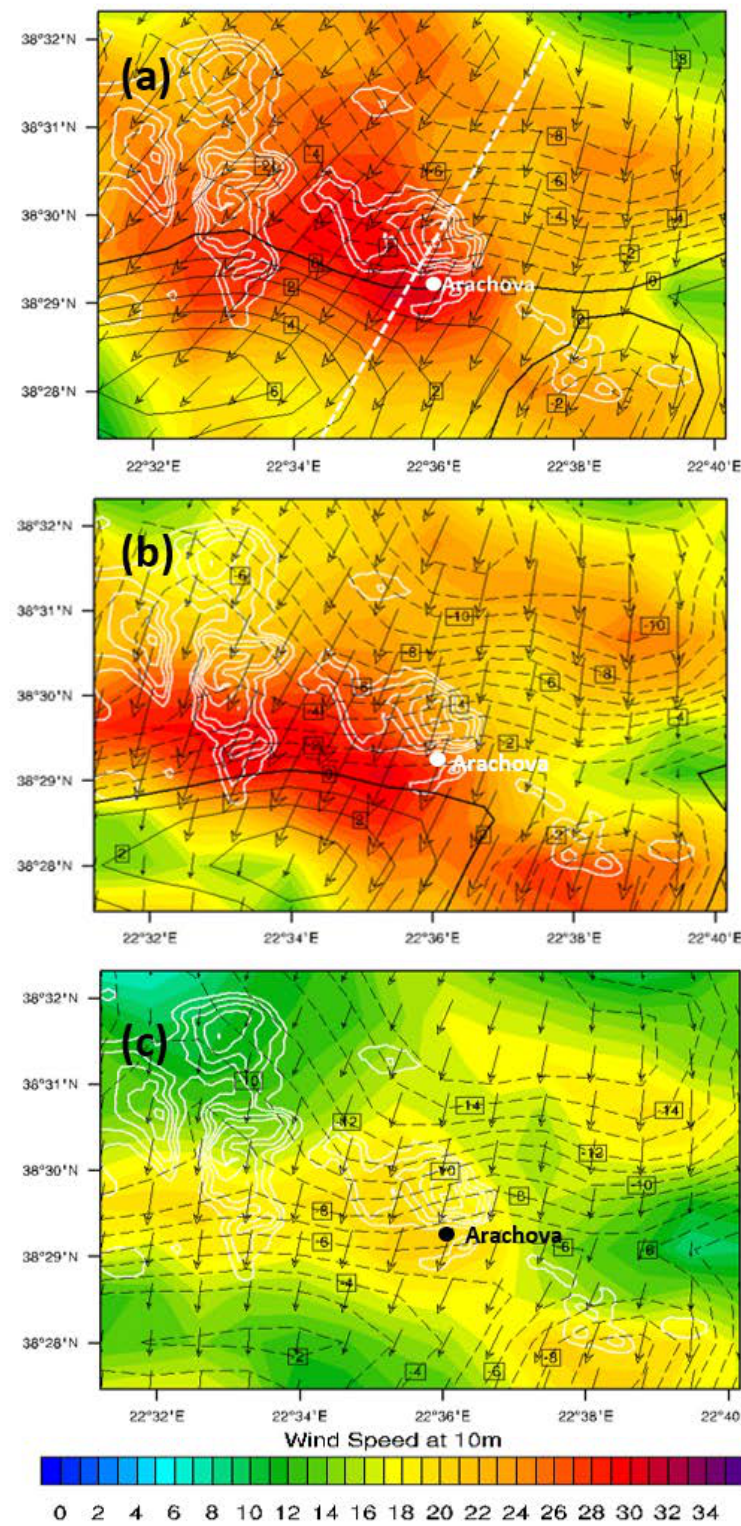
Figure 4. Topography (white contours every 250 m starting from 1000 m), temperature at 2 m (°C) (black contours) and wind speed and direction at 10 m (color scale in m s −1 ) at the time of the domain-maximum speed occurrence for each simulation: ( a ) 14 February 2019, 02:00 UTC. The location of Arachova and the location of the cross-section shown in following plots is also given here; ( b ) 6